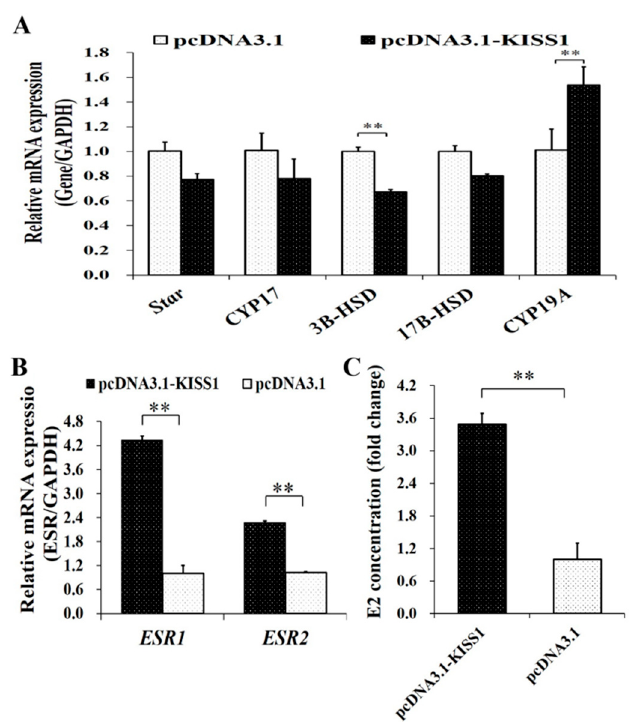
Figure 3. Biological Effects of KISS1 on synthesis of estrogen in GCs. ( A ) Effects of pcDNA3.1-KISS1 on the relative mRNA levels of Star , CYP17 , 3B-HSD , 17B-HSD , and CYP19A . ( B ) Concentrations of E2 was stimulated by pcDNA3.1-KISS1. ( C ) Effects of pcDNA3.1-KISS1 on the relative mRNA levels of ESR1 and ESR2 . ** indicates p < 0.01. Data were represented as means ± SD.